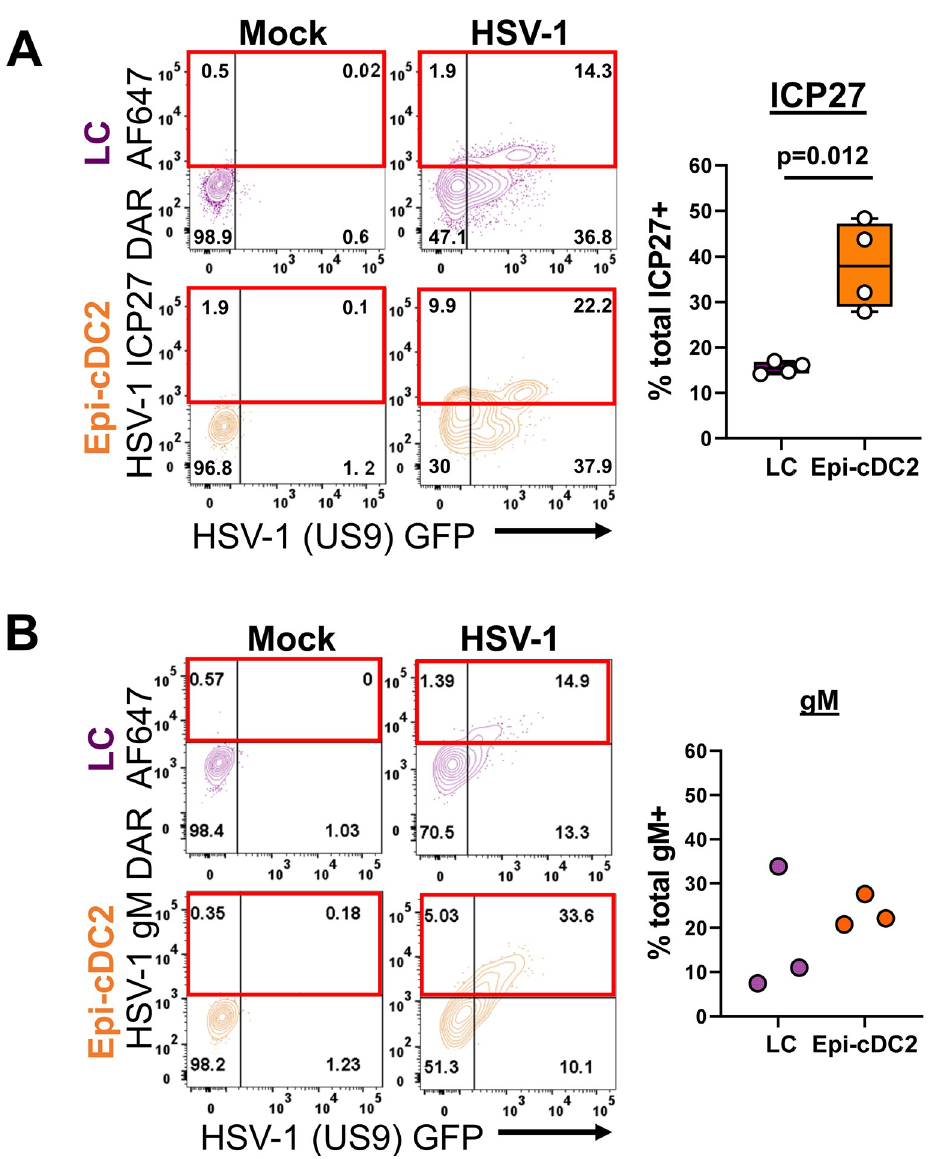
Fig 3. LCs and Epi-cDC2s express ICP27 and DNA-replication dependent late protein gM. A mixed population of epidermal MNPs was isolated from human abdominal epidermis and inoculated with HSV-1 GFP (MOI of 10) or mock treated for 1 h, then washed and incubated for a total infection time of 18 h in HaCaT-conditioned medium at 37˚C. The cells were then washed with PBS and labelled for flow cytometry as in Fig 2. Additionally, cells were permeabilized then followed by serial intracellular labelling with (A) biotin-conjugated anti-ICP27 then Alexa Fluor- 647 (AF647)-conjugated streptavidin, or (B) rabbit anti-HSV-1 gM then donkey-anti-rabbit (DAR) AF647. (A) The percentage of ICP27 AF647 + cells was analysed for each subset at 18 h, with gates set according to the mock condition. The graph shows box and whisker plots of the percentage of LCs (purple) and Epi-cDC2s (orange) expressing total ICP27, a combination of the ICP27 + GFP - and ICP27 + GFP + quadrants, indicated by the red boxes. A two-tailed paired t-test was used to compare the percentage of ICP27 + LCs and Epi-cDC2s, n = 4. (B) The percentage of gM AF647 + cells was analysed for each subset at 18 h, with gates set according to the mock condition. The graph shows the percentage of LCs (purple) and Epi-cDC2s (orange) expressing total gM, a combination of the gM + GFP - and gM + GFP + quadrants, indicated by the red boxes, n =